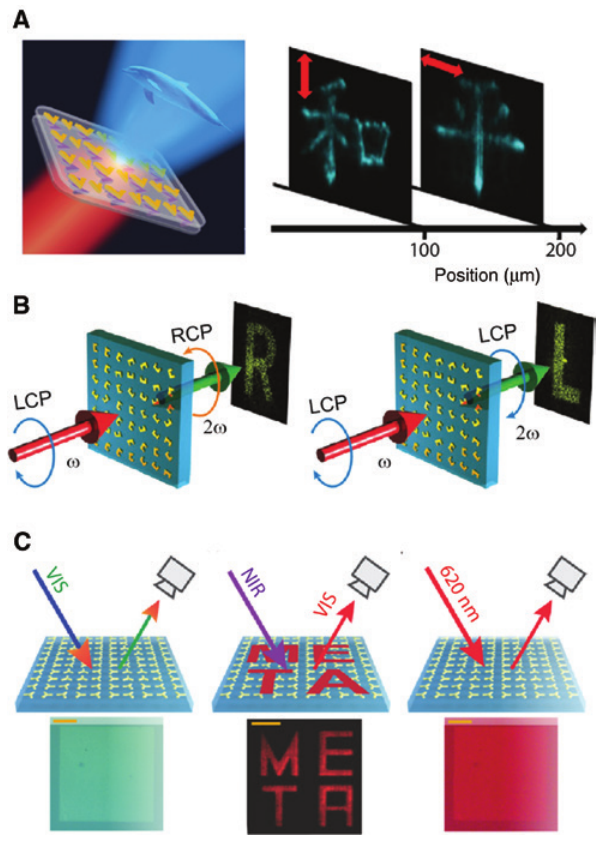
Figure 4: Nonlinear optical holography and encryption. (A) Nonlinear metasurface holography. The local P-B phase of SHG wave comes from the orientation of the SRR meta-atoms and circular polarization of FW. This technique allows encoding different images into one metasurface using two opposite polarization states, which correspond to different P-B phases. (B) Nonlinear holography using THG from V-shaped meta-atoms. (C) Nonlinear metasurface for information encryption. If the metasurface is illuminated with unpo- larized white light, no image can be observed. Under pumping of circularly polarized FW at the wavelength of 1240 nm, an image with the characters “META” appears at the SHG wavelength (620 nm); for a direct illumination with unpolarized light at a wavelength of 620 nm, no information on the “META” characters is observed. A is adapted from Ref. [86], B from Ref. [71], and C from Ref.